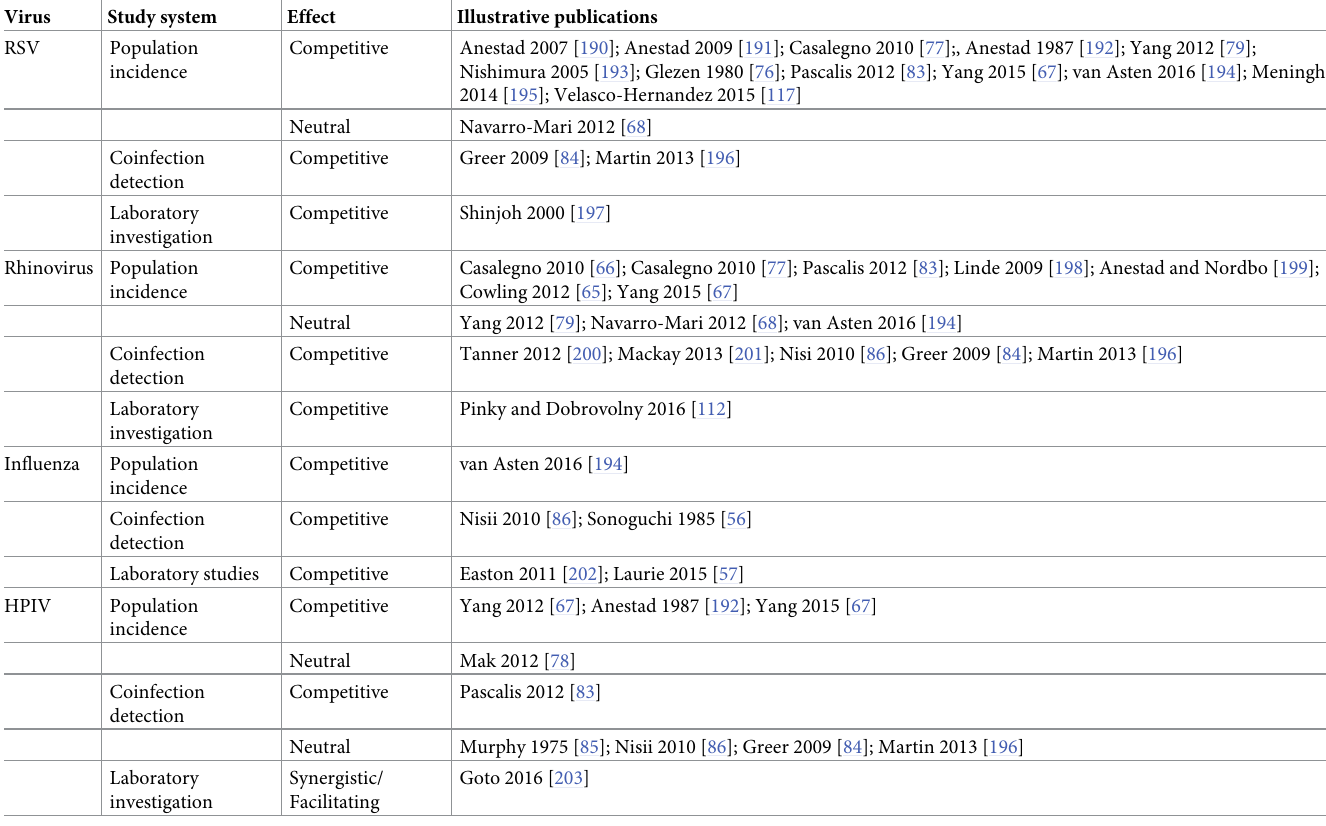
Table 2. Viruses that may be affected by interaction with